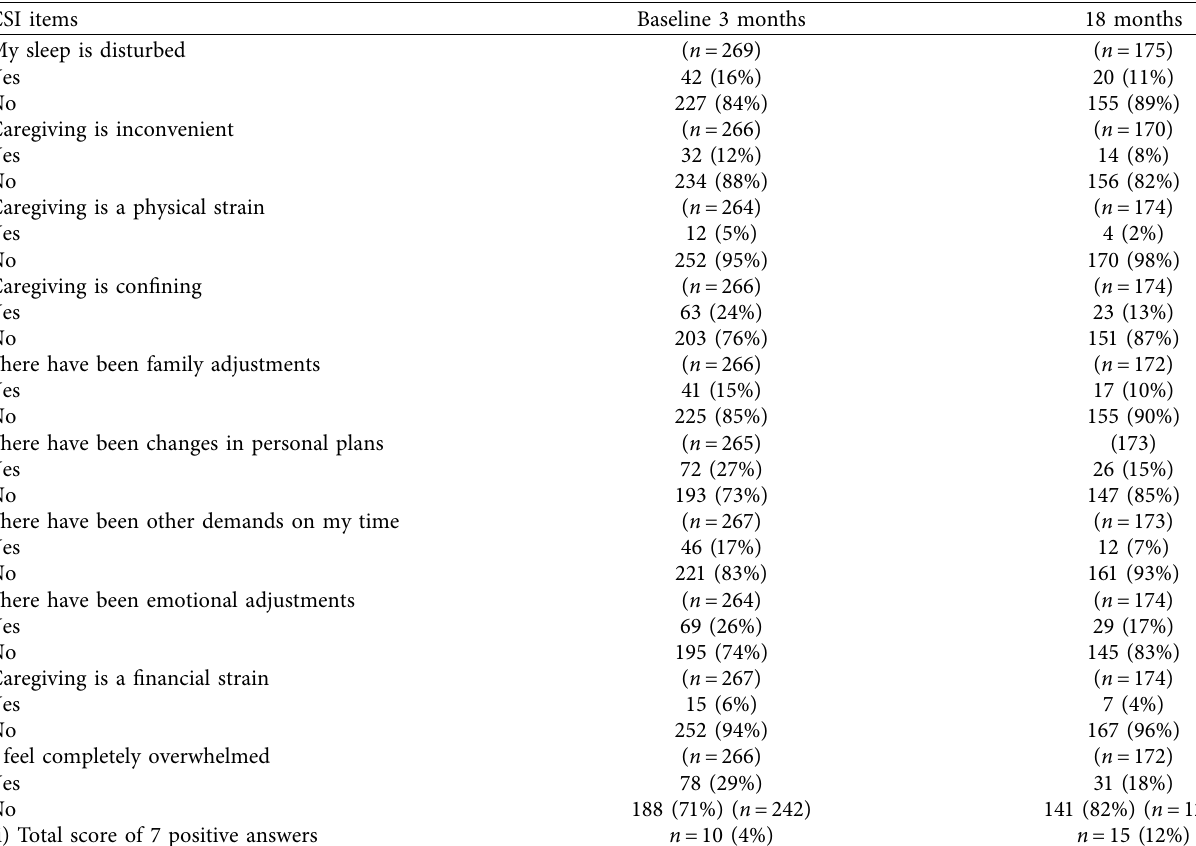
Table 2: All reported answers of Caregiver Strain Index (CSI) items at baseline 3 and 18-month follow-up. The yes/no answers are reported in frequencies ( n ) and percentages (%). In addition, a total score of more than 7 positive answers is reported reflecting a high burden of caregiver strain.